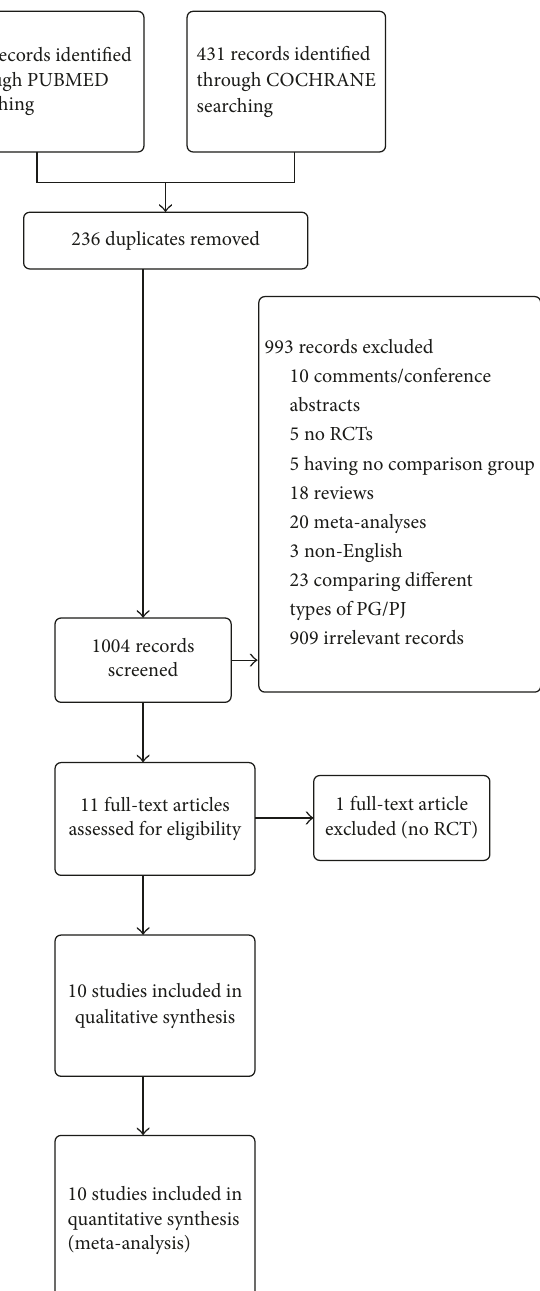
Figure 1: Study flow